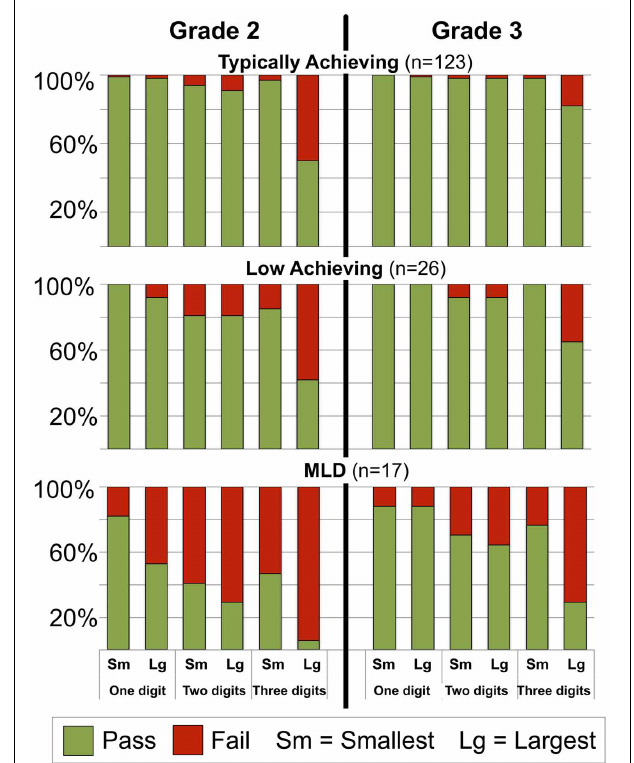
FIGURE 1 | The percentage of all children in the study who correctly or incorrectly responded to each of six items on the Written Numbers Task. This performance summary reveals developmental and group differences from Grades 2 to 3 among children with typical achievement (TA) or low achievement (LA) in mathematics or mathematical learning disability